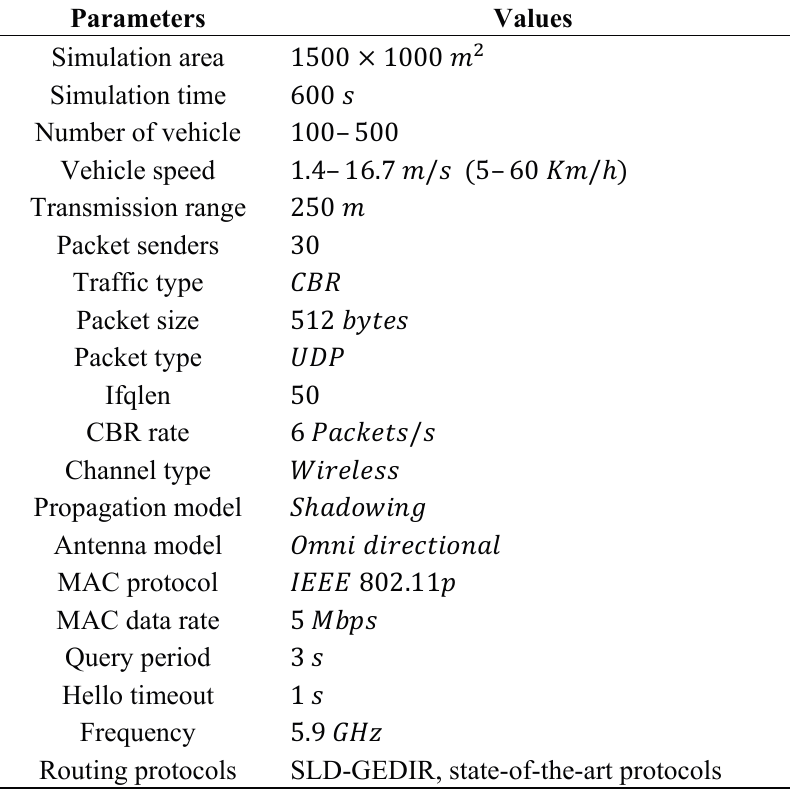
Table 1. Simulation